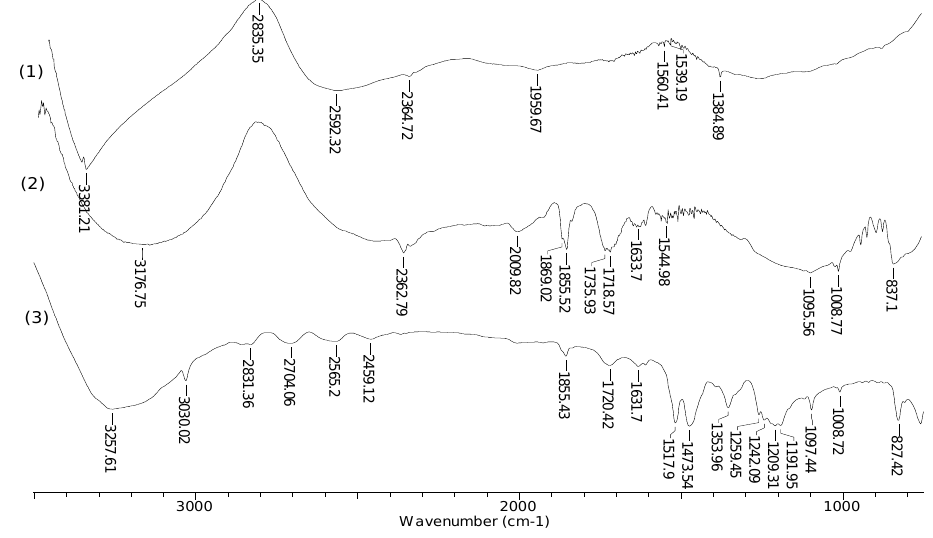
Figure 6. FTIR spectra of PET waste (1), 8-Ph-PET (2), and 2-OH-Ph-PET (3).